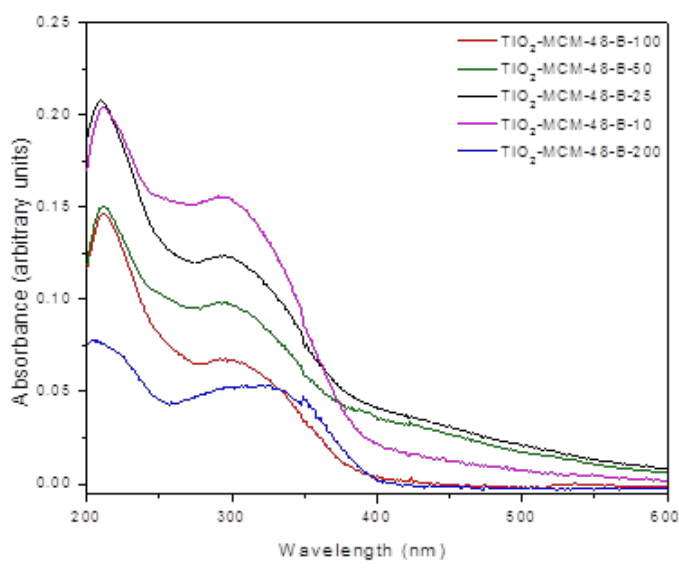
Figure 7. UV-Vis DR spectra of TiO 2 -MCM-48-materials with different titania